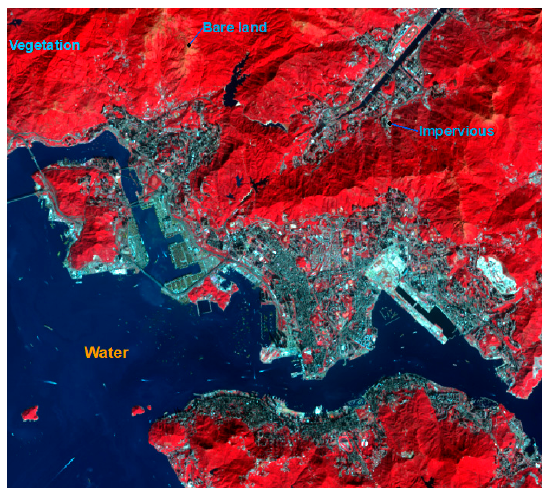
Figure 3. False color image of Hong Kong. Typical land covers: water (dark blue), vegetation (red), bare land (yellow), and impervious (bluish ash).